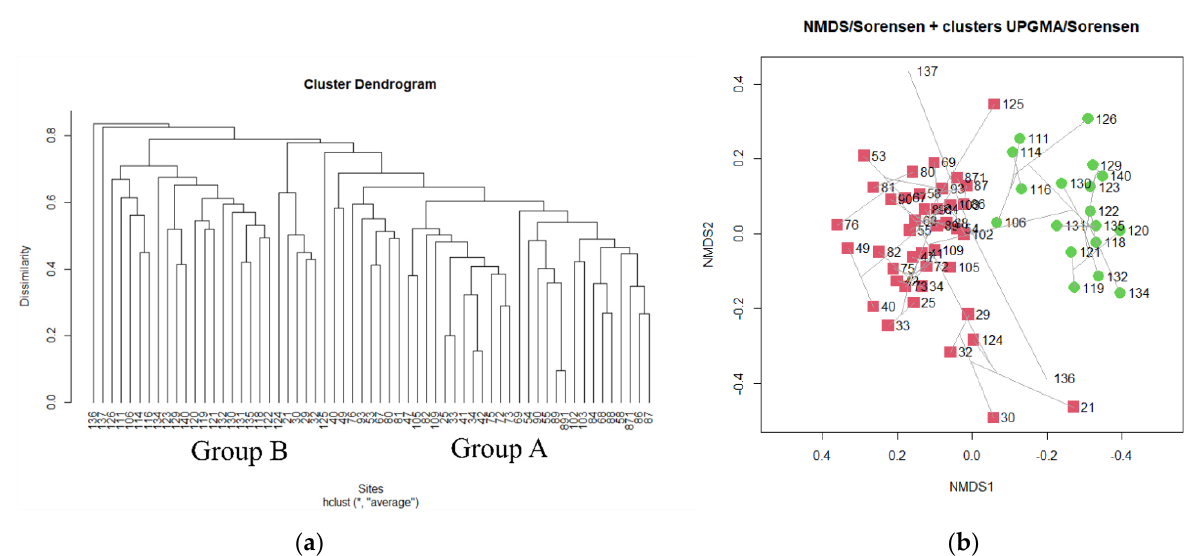
Figure 3. ( a ) Cluster analysis based on Sørensen’s dissimilarity; ( b ) Non-metric multidimensional scaling analysis based on Sørensen’s dissimilarity (Stress = 0.2). Both analyses show the characterization of two distinct polychaete assemblages on the continental shelf of the Gulf of Mexico. Red squares represent the terrigenous group, green circles group the carbonate stations.